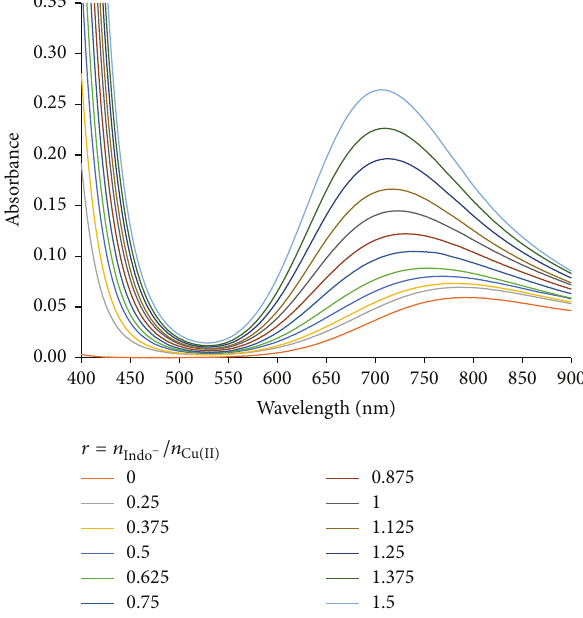
Figure 3: UV-Vis spectra of Cu(II)–Indomethacin in ethanol applying the molar ratio method with fixed concentration of Cu(II) and variable concentration of Indo − .